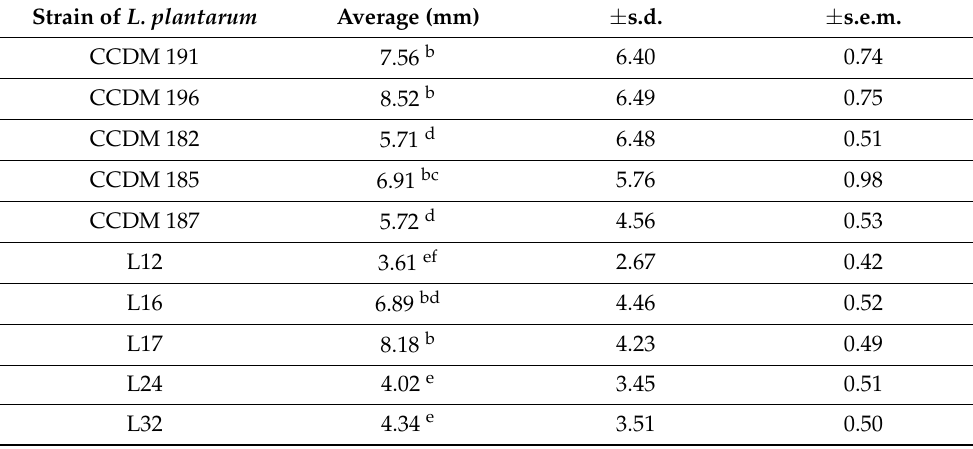
Table A3. The variability in the average size of yeast colonies (mm) including standard deviation (s.d.) and standard error of mean (s.e.m.) on RSM medium with L. plantarum strains, including the control variant, for all yeast strains. Factorial ANOVA, Statistica Software v. 12, F (20,1530) = 45.604; p ≤ 0.5 ≤ α . The index letter indicates significant differences. Significant at α ≤ 0.05. Strain of L.